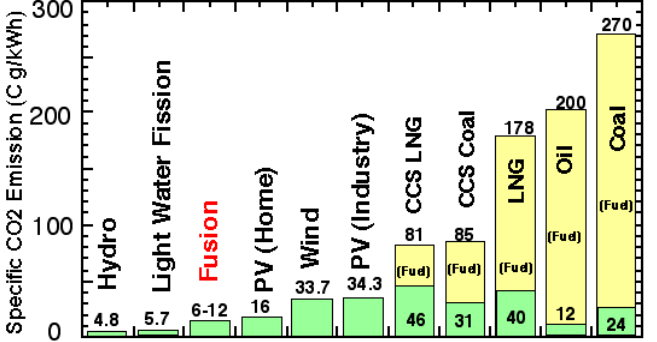
Figure 32. Specific CO emission of fired (coal, oil, natural gas), renewables (solar, wind), 2 fission and fusion plants. Green and yellow indicate CO emission by construction and fuel 2 burn, respectively. Abbreviations are Carbon Capture and Sequestration (CCS) and Photo Voltaic (PV).